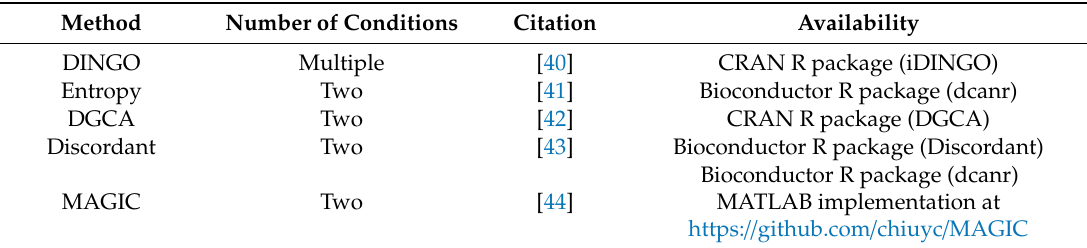
Table 2. “Global network” methods that can also be employed for the “gene-specific” approach.